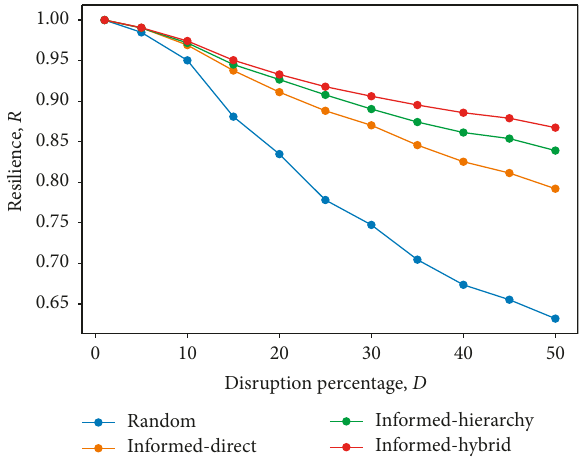
Figure 9: Resilience curves of all recovery strategies. These results show how system resilience can be improved by configuring the informational